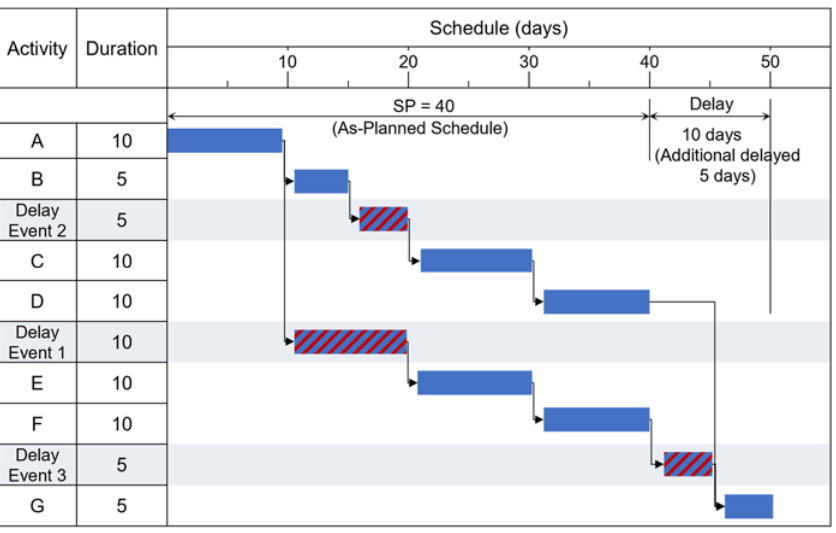
Figure 8. Impact of delay events 1, 2, and 3.